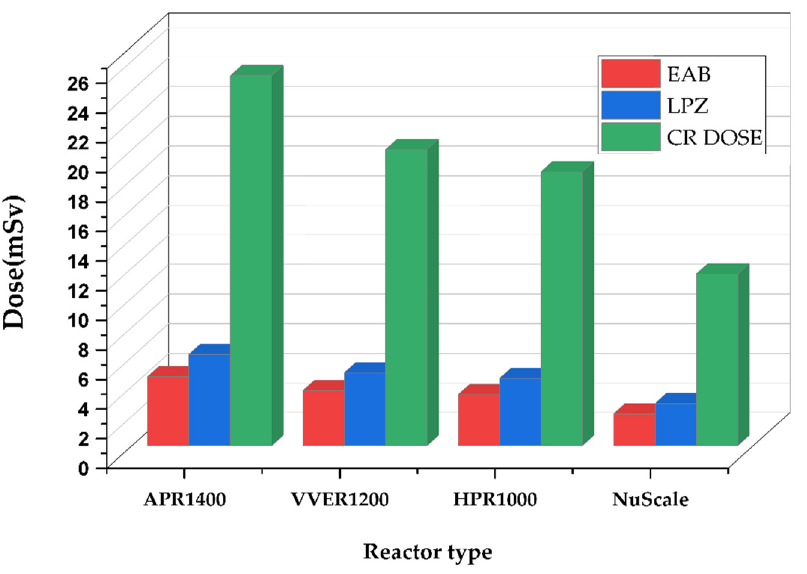
Figure 5. FHA TEDE comparison of exclusion area boundary, low population zone, and main con- trol room. Table 5. Comparison of FHA Analysis using verified DCD results [23].